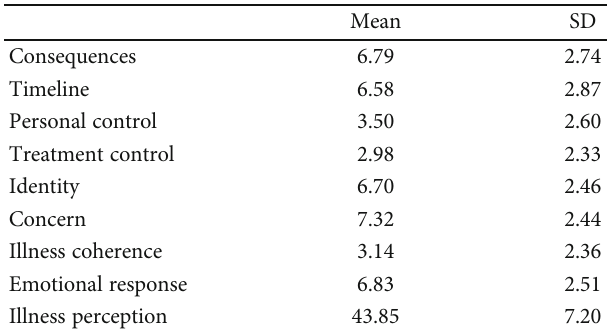
Table 2: Descriptive statistics for illness perception in patients with